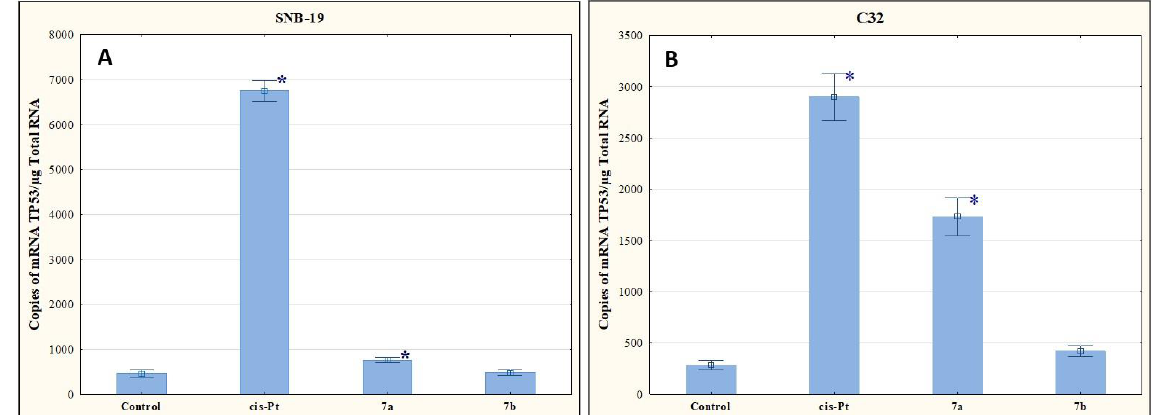
Figure 7. The effect of compounds 7a and 7b on transcriptional activity of TP53 for SNB-19 ( A ) and C-32 ( B ) cells. Cells were exposed to compound 7a and 7b for 24 h at a concentration equal to half of IC 50 determined for SNB-19 (0.3 and 0.25 µg/mL, respectively) and for C-32 (0.7and 0.25 µg/mL, respectively). For the reference compound, cisplatin, the appropriate concentrations were 0.8 µg/mL (SNB-19 line) and 0.6 µg/mL (C32 line). * p < 0.05 compared with the untreated control.